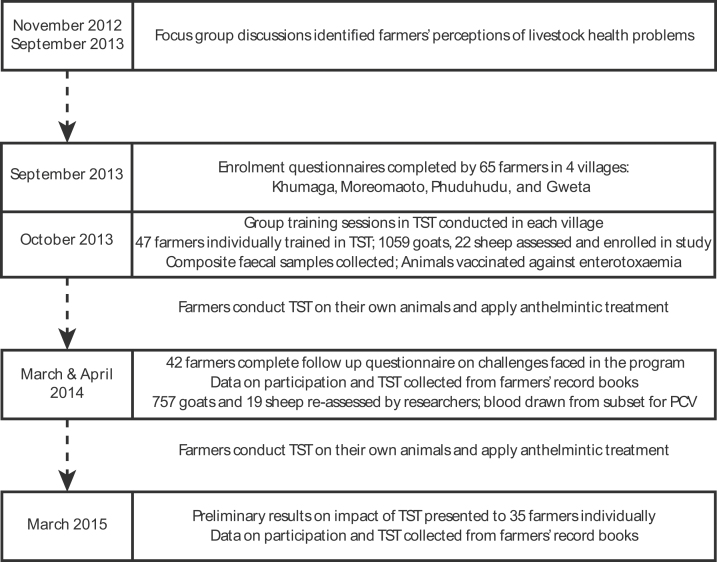
Flowchart of mixed methods, multi-phase study design. Key time points in the study are represented, additional detail on each phase is in the online Supplementary material.